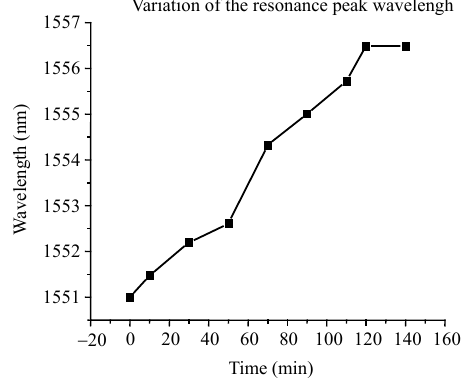
Fig. 8 Resonance peak wavelength changes over time in antigen-antibody hybridization